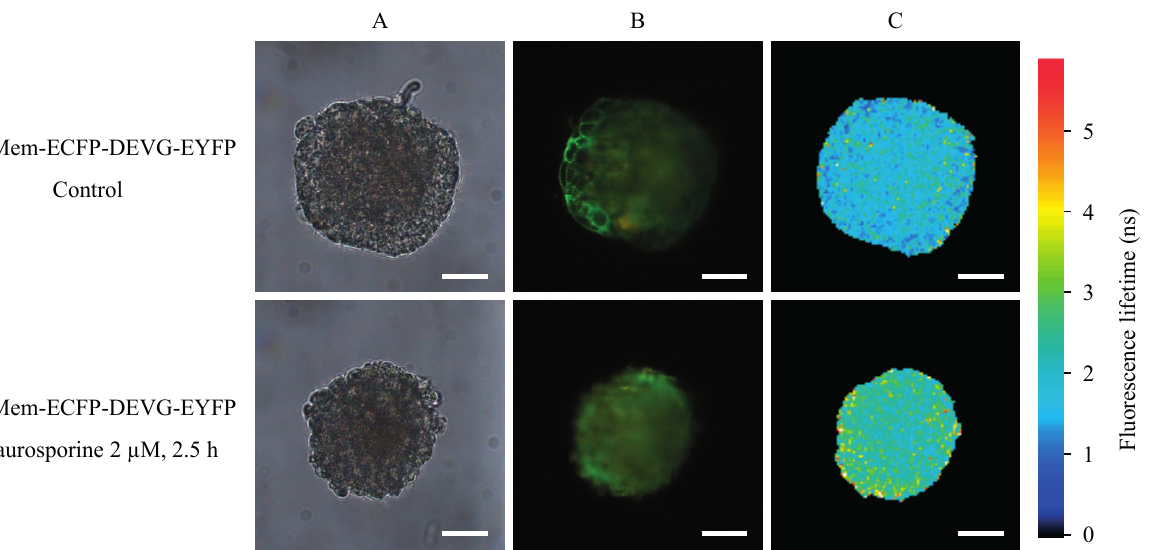
Figure 4. Transillumination ( A ), fluorescence intensity ( λ ≥ 515 nm); ( B ) and fluorescence lifetime (450–490 nm); ( C ) of HeLa cervical carcinoma cells transfected with a Mem-ECFP-DEVG-EYFP encoding vector prior to and subsequent to application of staurosporine (2 µM, 2.5 h). Light sheet based fluorescence microscopy of individual layers of a multicellular spheroid with 6–10 µm thickness each. Excitation wavelength: 391 nm. Scale bars: 50 µm.